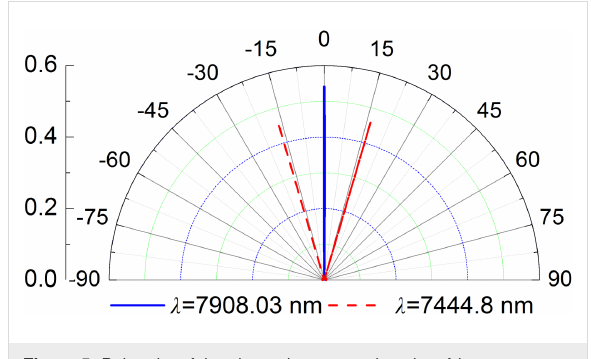
Figure 5: Polar plot of the absorption at wavelengths of λ 1 = 7908.03 nm and λ 2 = 7444.8